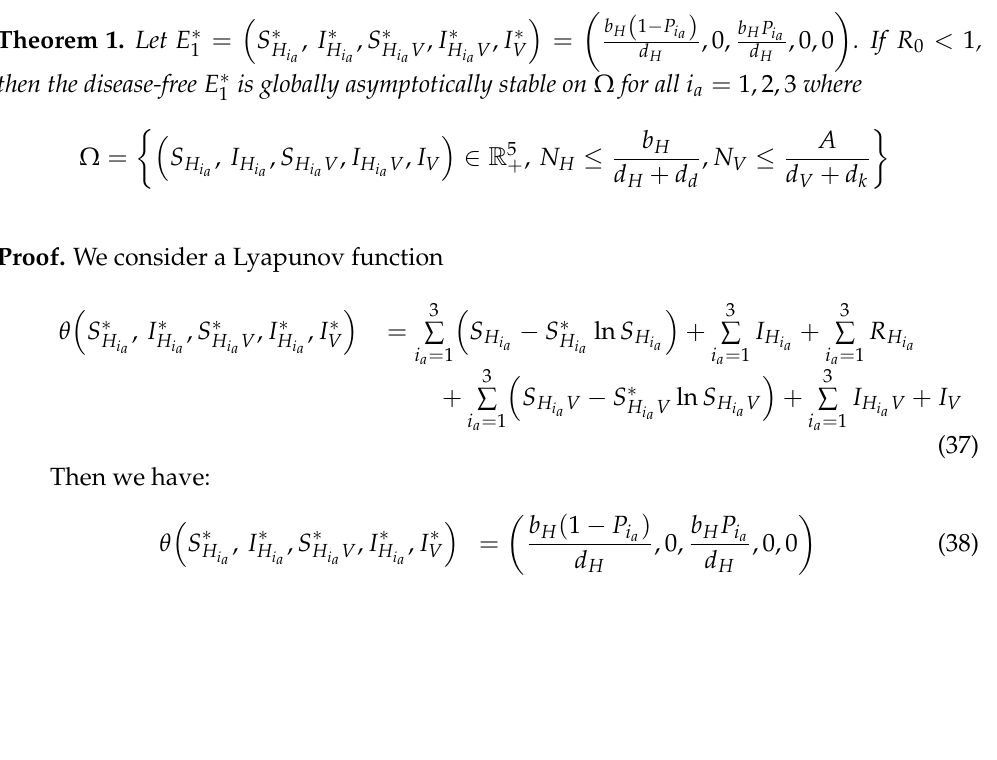
* E is globally asymptotically stable on Ω for all 1